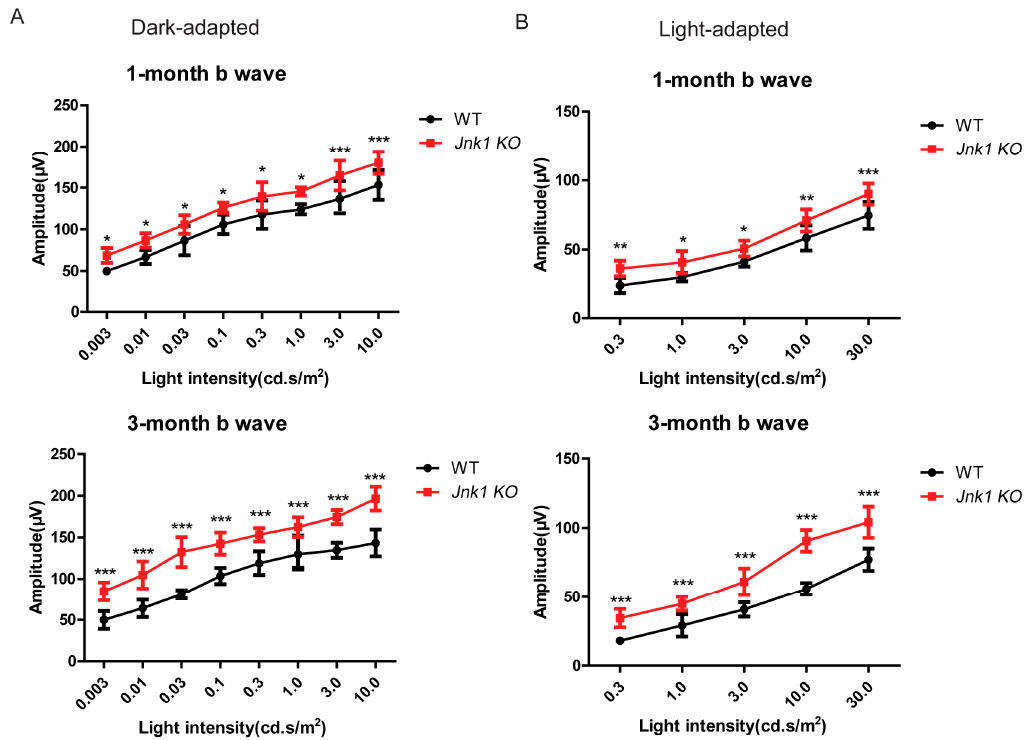
Figure 3. Enhanced ERG (electroretinogram) responses in the Jnk1 KO mice. ( A ) Amplitudes of ERG b-waves elicited from WT and Jnk1 KO mice aged 1 and 3 months. ( B ) Amplitudes of ERG b-waves elicited from WT and Jnk1 KO mice aged 1 and 3 months. Differences between WT and Jnk1 KO animals were significant at all flash intensities. Graphs show the mean ± SEM, and the data shown are representative of four mice. * p < 0.05, ** p < 0.01, *** p < 0.001 (Wilcoxon–Mann–Whitney test).